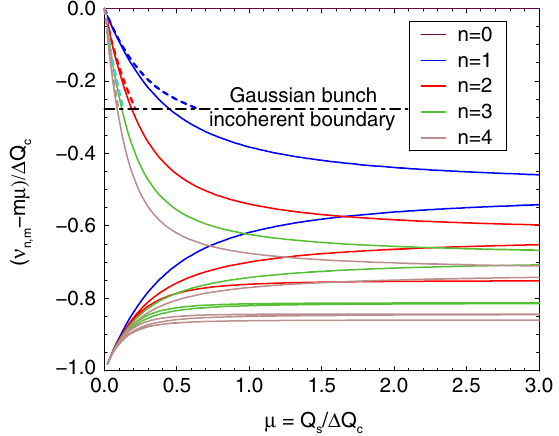
FIG. 13. Transformed eigentunes against synchrotron tune: solid lines—boxcar model; dashed lines—Gaussian bunch with 3 (cid:15) truncation. Space charge tune shift in the bunch center is used for scaling. Averaged over time incoherent betatron tunes are located below the presented incoherent